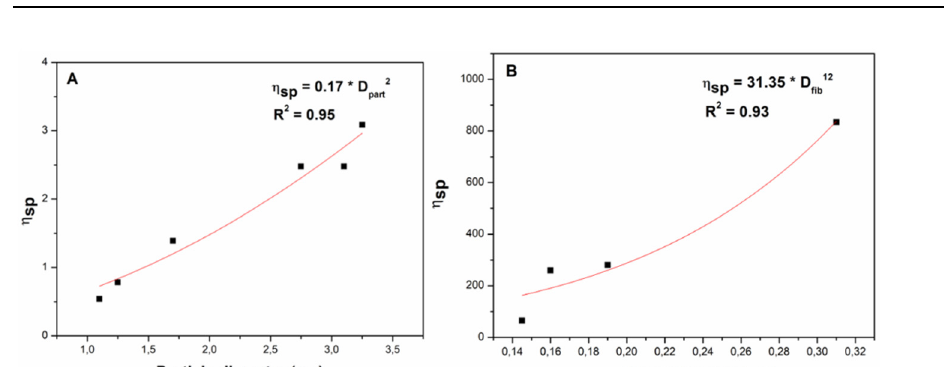
Figure 6. Empirical correlation between specific viscosity of solutions with ( A ) particle diameter and ( B ) fiber diameter obtained for the AC and EC